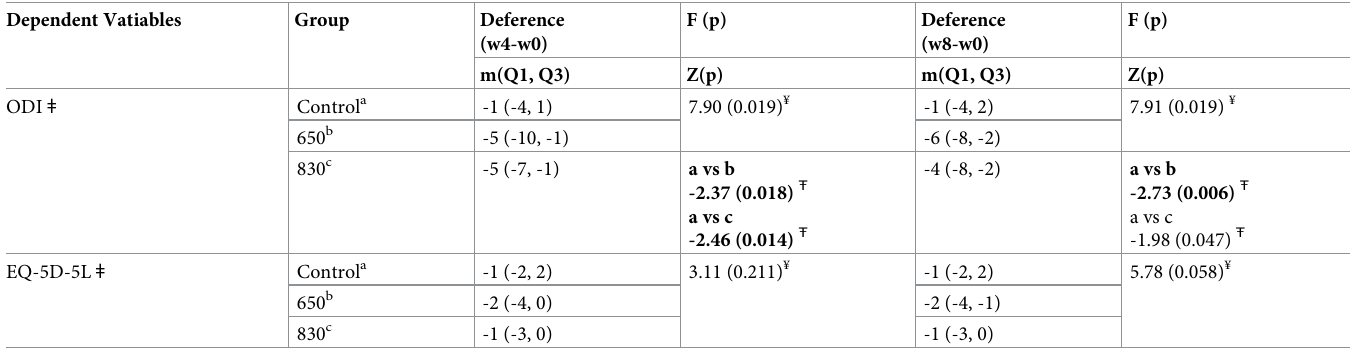
Table 5. Difference in changes in ODI and EQ-5D-5L scores among three groups (n = 45). Dependent